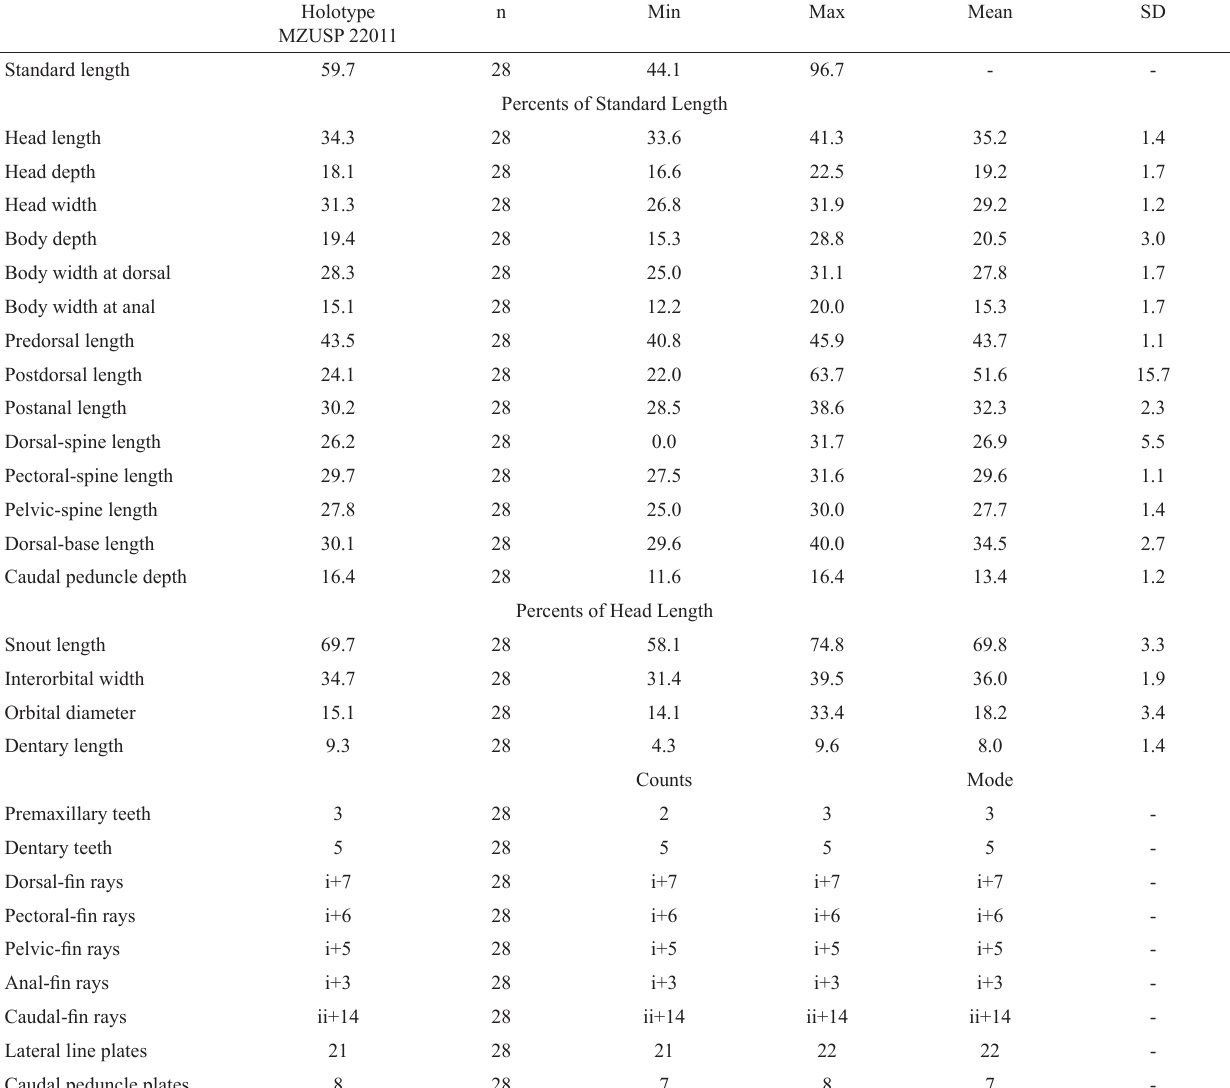
Table 1. Morphometric and meristic data of Spectracanthicus murinus . Values are given as percents of standard length or head length. SD = standard